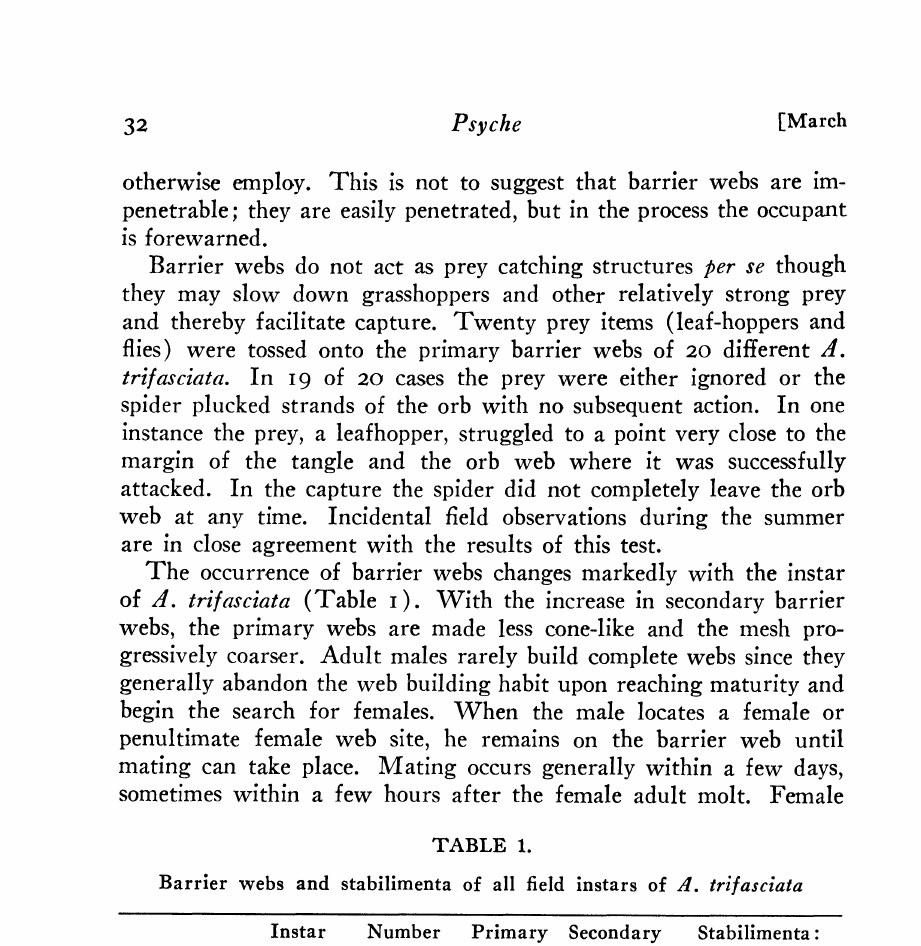
Barrier webs and stabilimenta of all field instars of ./1.